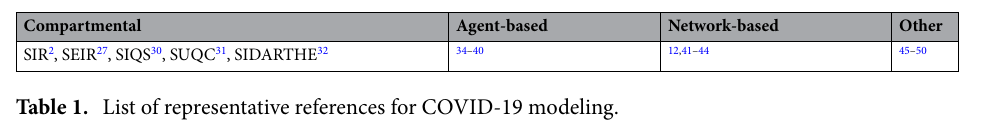
Table 1. List of representative references for COVID-19 modeling.